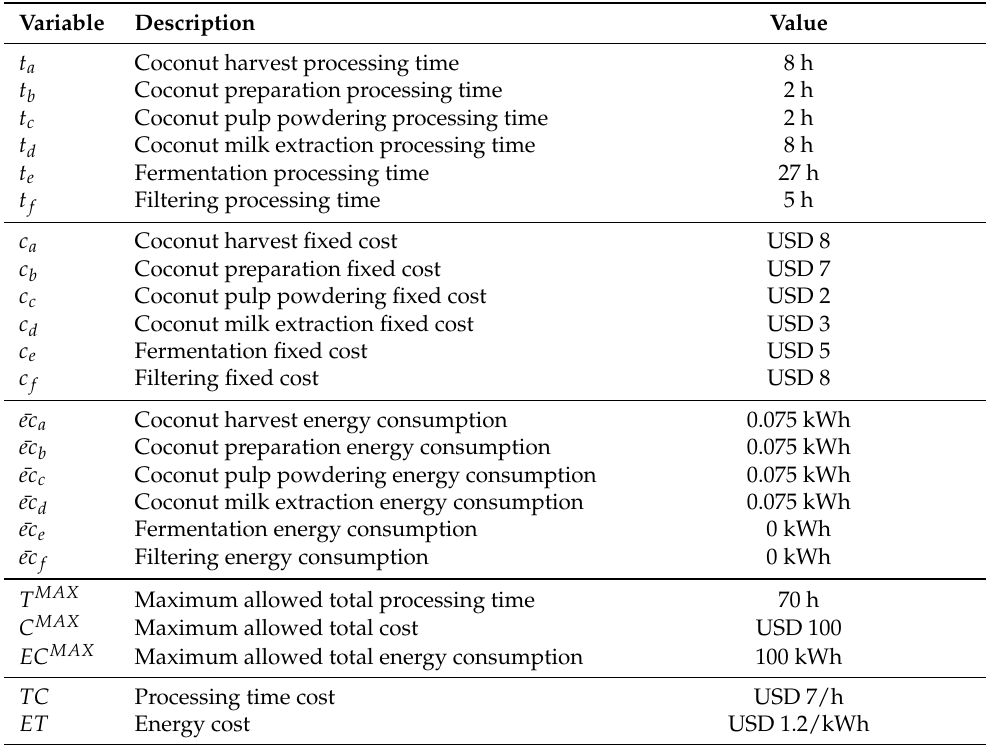
Table 3. Life cycle inventory (LCI) data: decision-making approach variables for fermentation-based extraction method ( i =